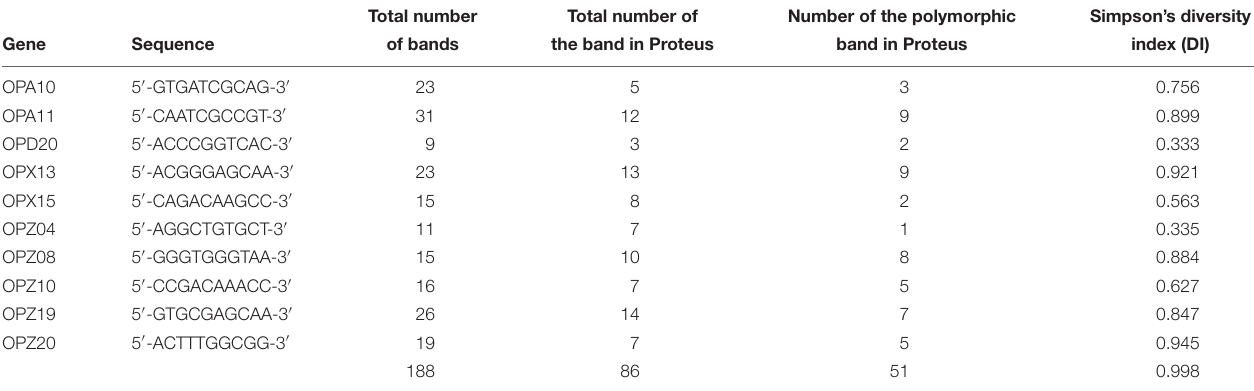
TABLE 1 | Primers sequence for